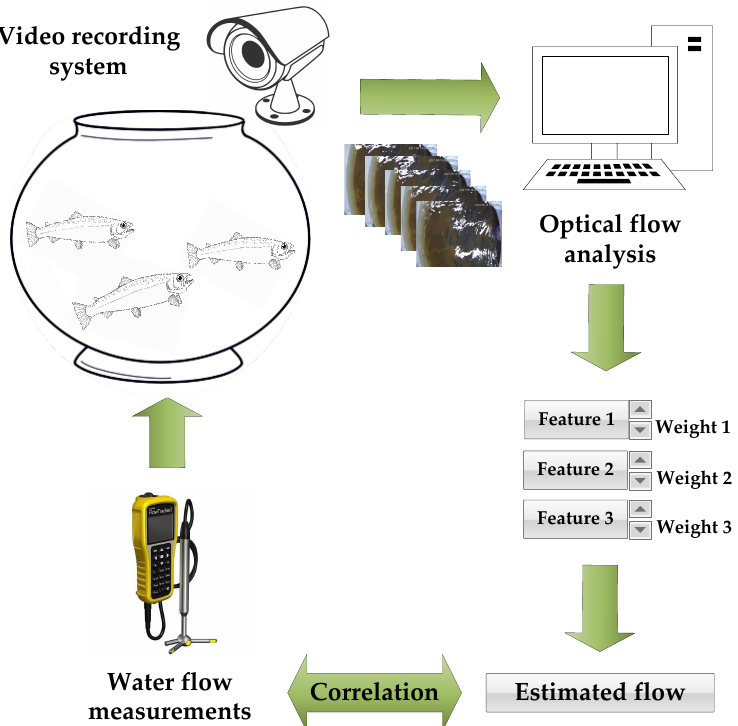
Figure 4. The simplified flowchart illustrating the idea of the proposed